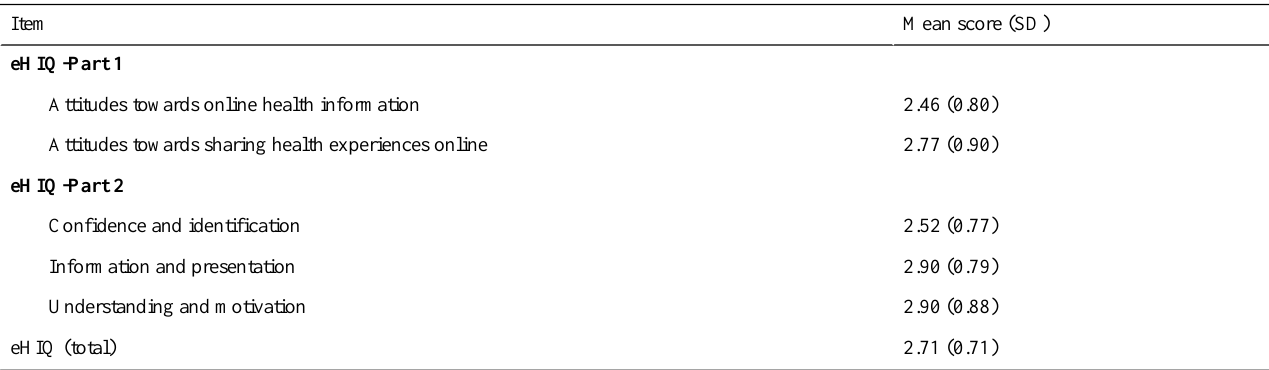
Table 2. Mean scores for online health information–seeking behavior of the